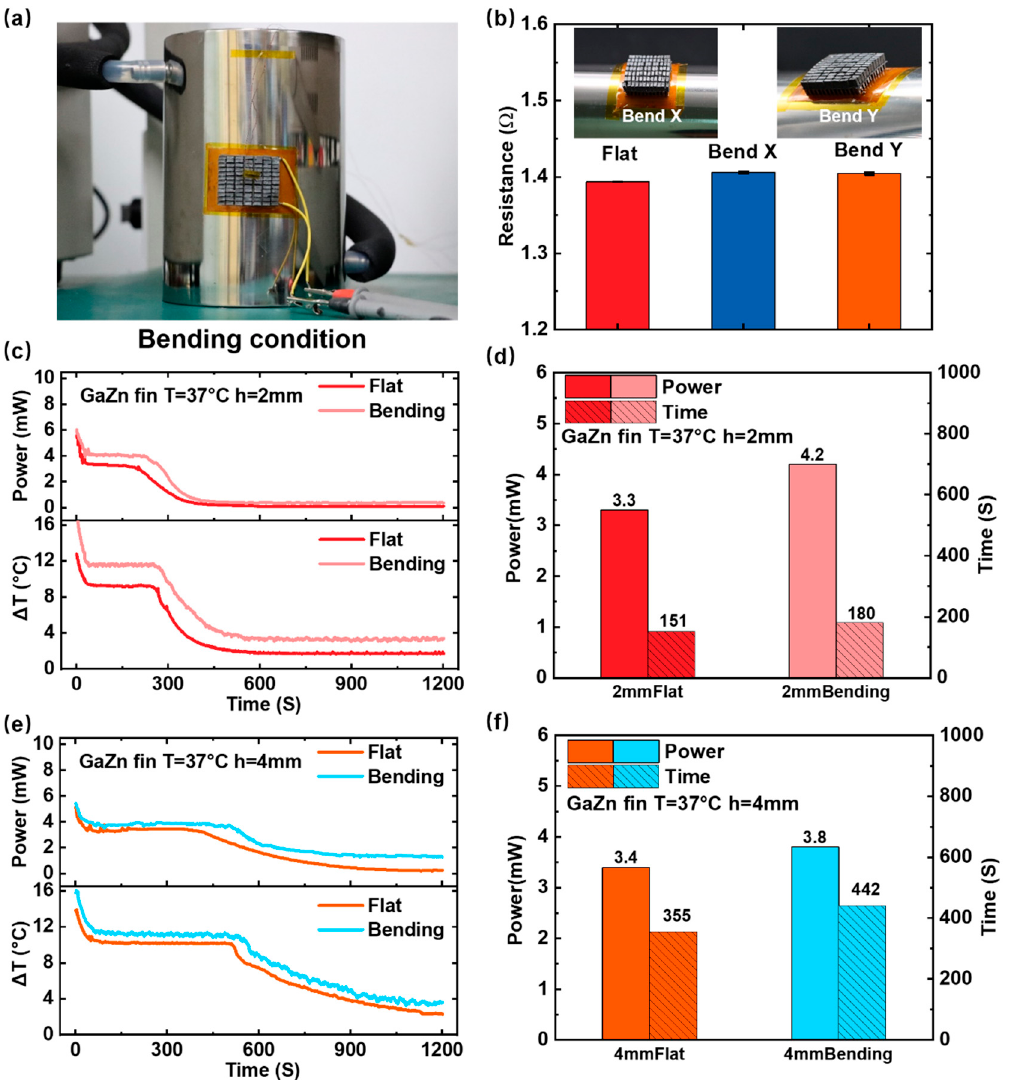
Figure 5. The impacts of the bending on the LM-WTEG performance: ( a ) the test platform; ( b ) the internal electric resistances of LM-WTEG; ( c ) the output power and temperature difference and ( d ) the corresponding phase change time for GaZn fin height of 2 mm; and experiment results of ( e ) and ( f ) for fin height of 4 mm.